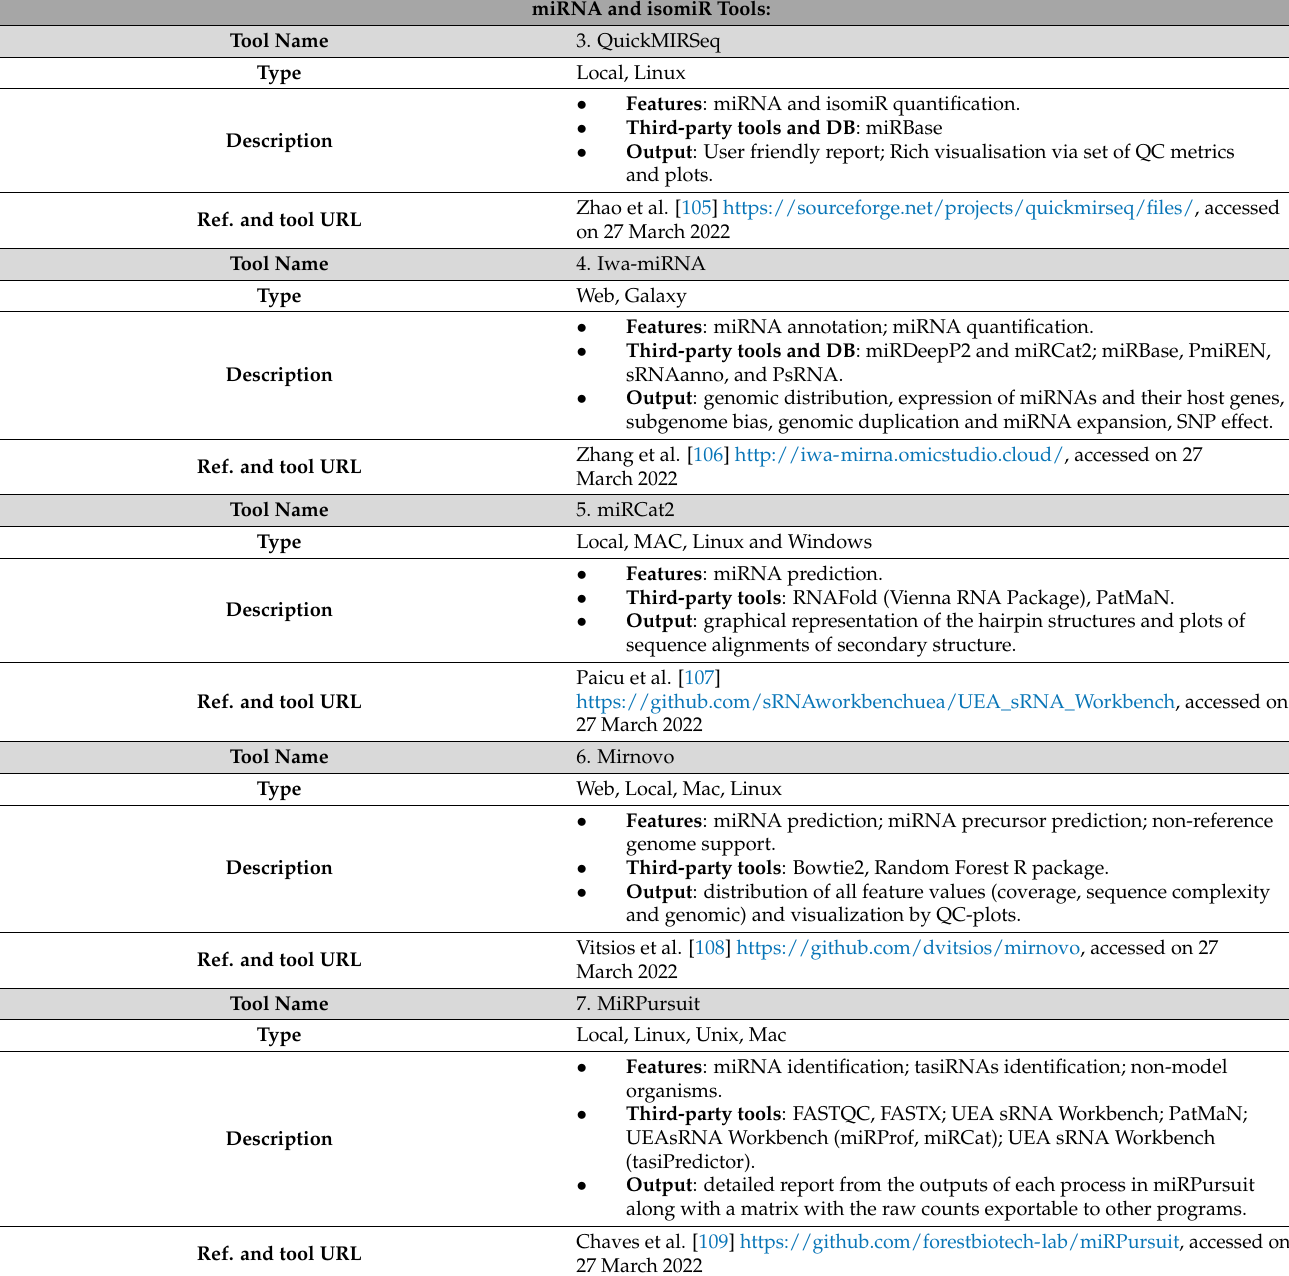
miRNA and isomiR